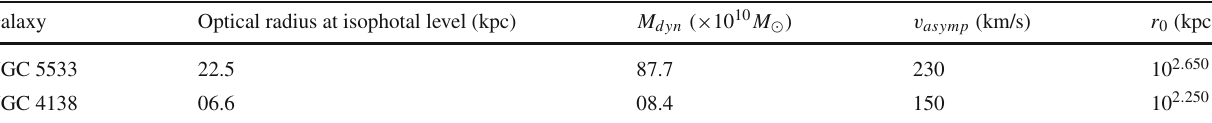
Table 1 Specifications of galaxies: Galaxies for which the f ( R ) galactic length scale parameter, i.e., r 0 is obtained via plotting the viable outer rotation velocity profiles by using Eq. (7). The observed data is culled from [52–54].